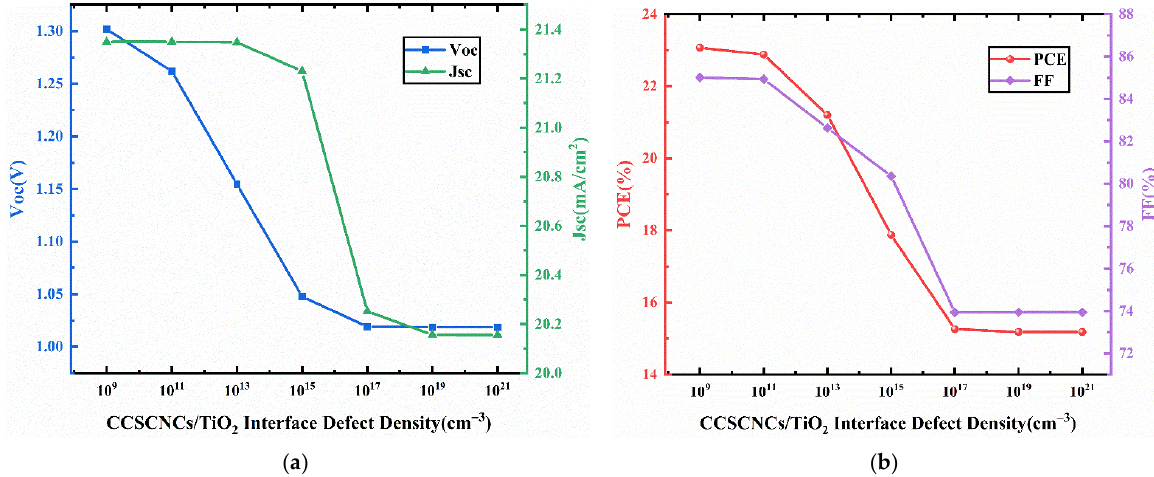
Figure 16. ( a ) Change in Voc and Jsc against CCSCNCs/TiO 2 interface defect density variation; ( b ) change in PCE and FF against CCSCNCs/TiO 2 interface defect density variation.